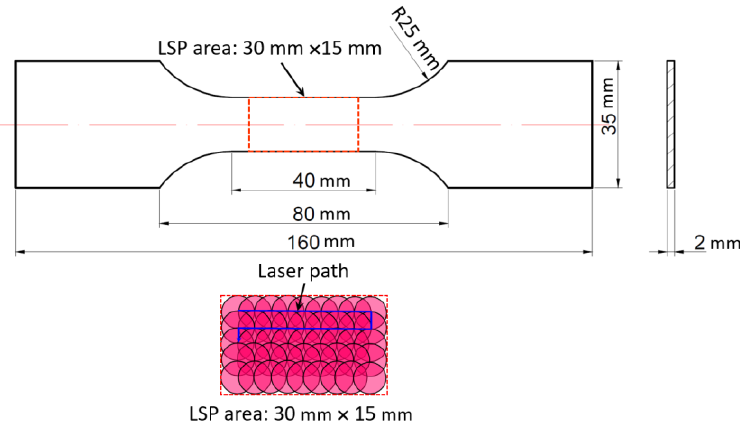
Figure 2. Schematic of tensile specimen dimensions, LSP area and path.